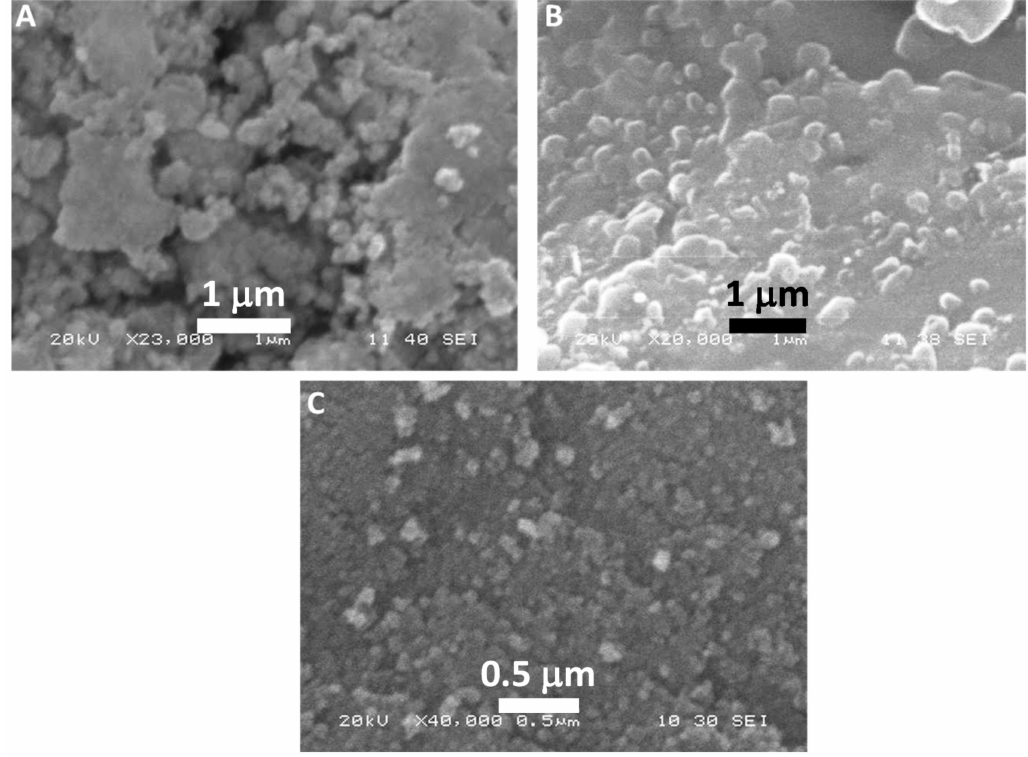
Figure 4. SEM-based comparative analysis of morphologies of TCE-Ag-1 ( A ), TCE-Ag-2 ( B ), and TCE-Ag-3 ( C )